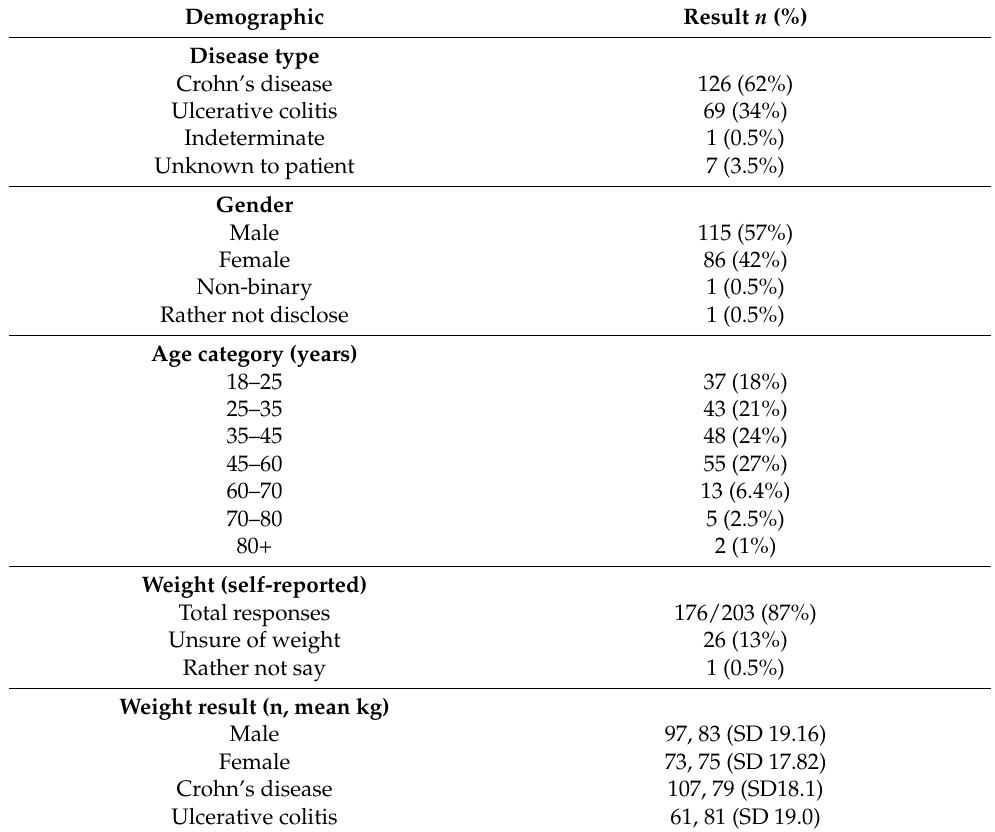
Table 1. Patient demographics.